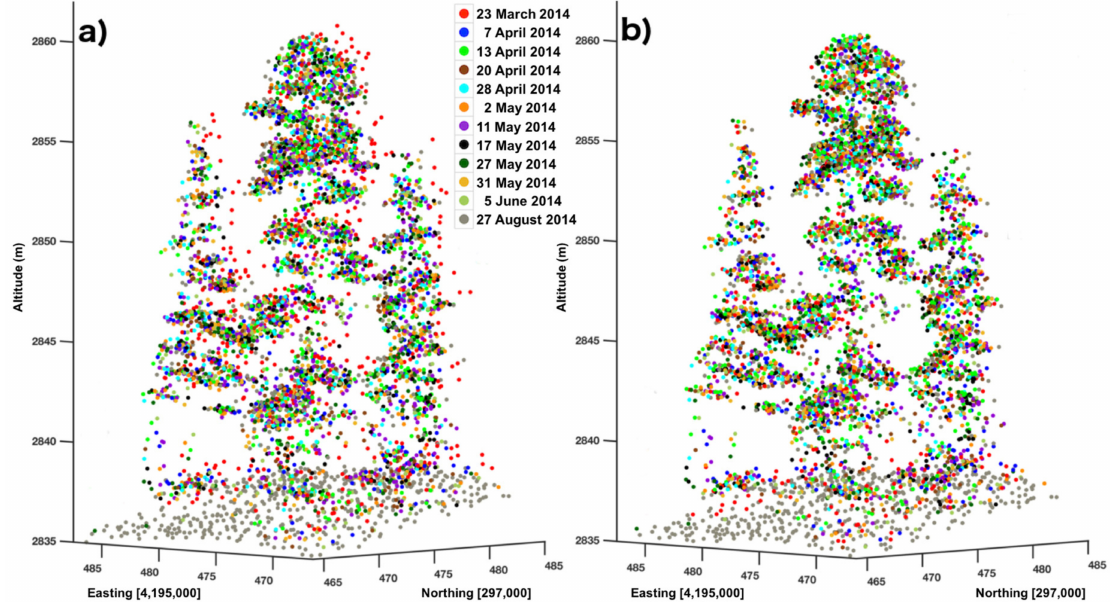
Figure 5. Point cloud composites around tie object T1 (Figure 4a) ( a ) before and ( b ) after the registration of the individual datasets. Colors correspond to acquisition dates. The x and y axis correspond to the UTM coordinates and ellipsoidal altitude,